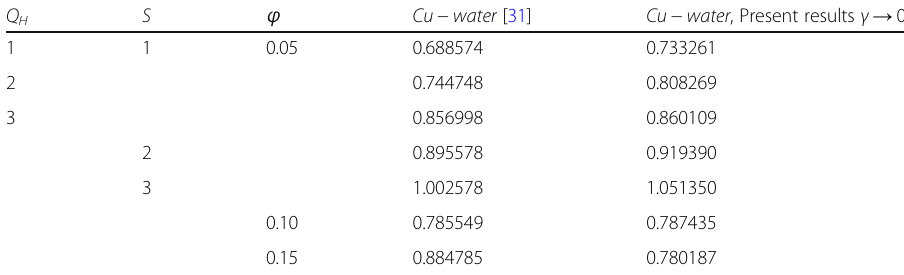
Table 4 Comparison of results for the local Nusselt number ( Nu /Re x ) Q H S ϕ Cu − water